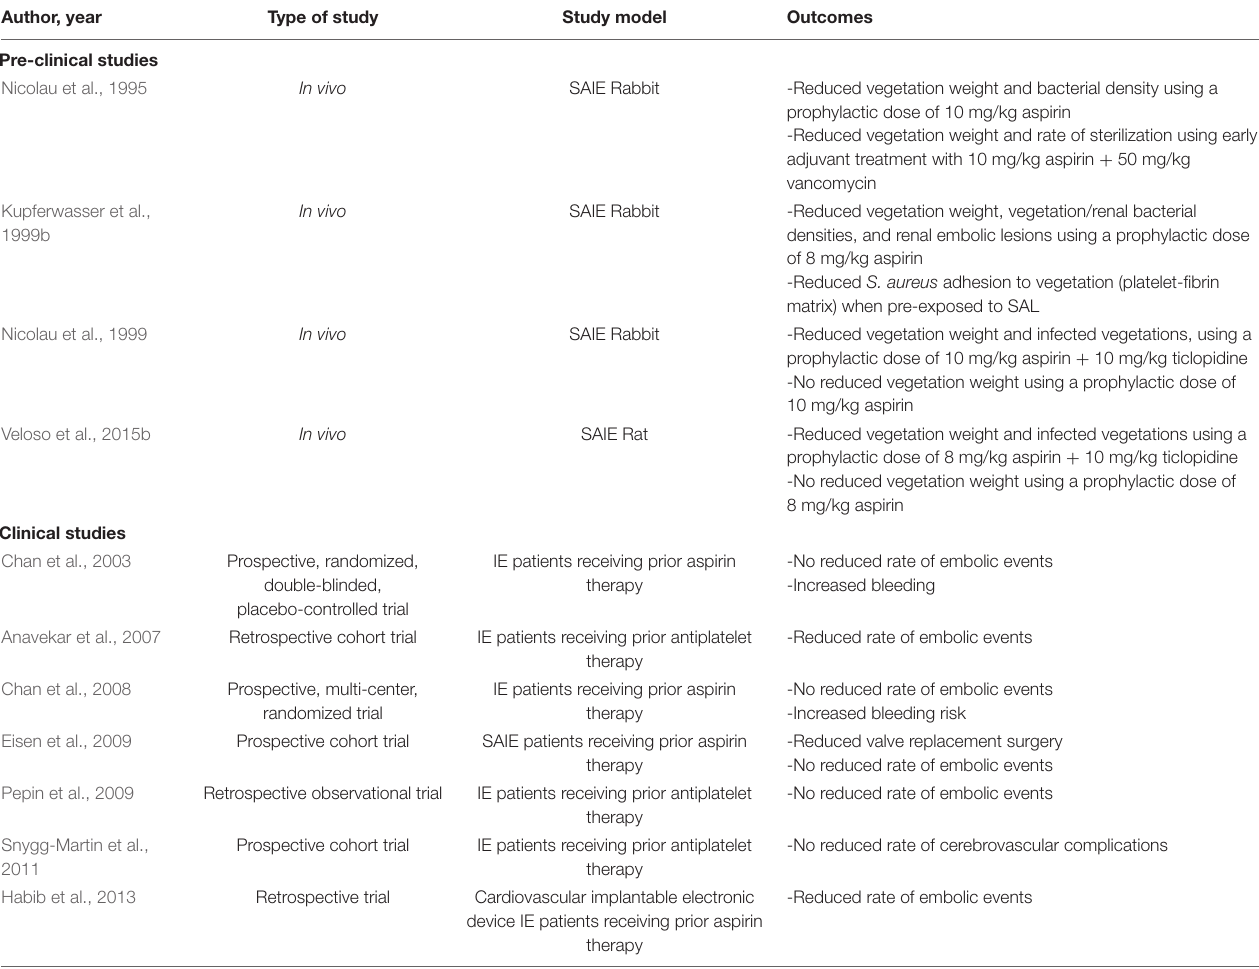
TABLE 1 | Overview of pre-clinical and clinical studies on the use of antiplatelet therapy in the prevention of infective